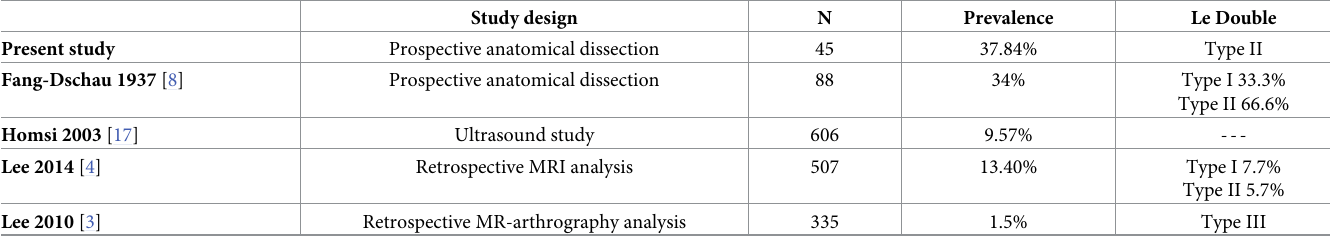
Table 2. Prevalence and Le Double classification relative to previous studies. N = number of included